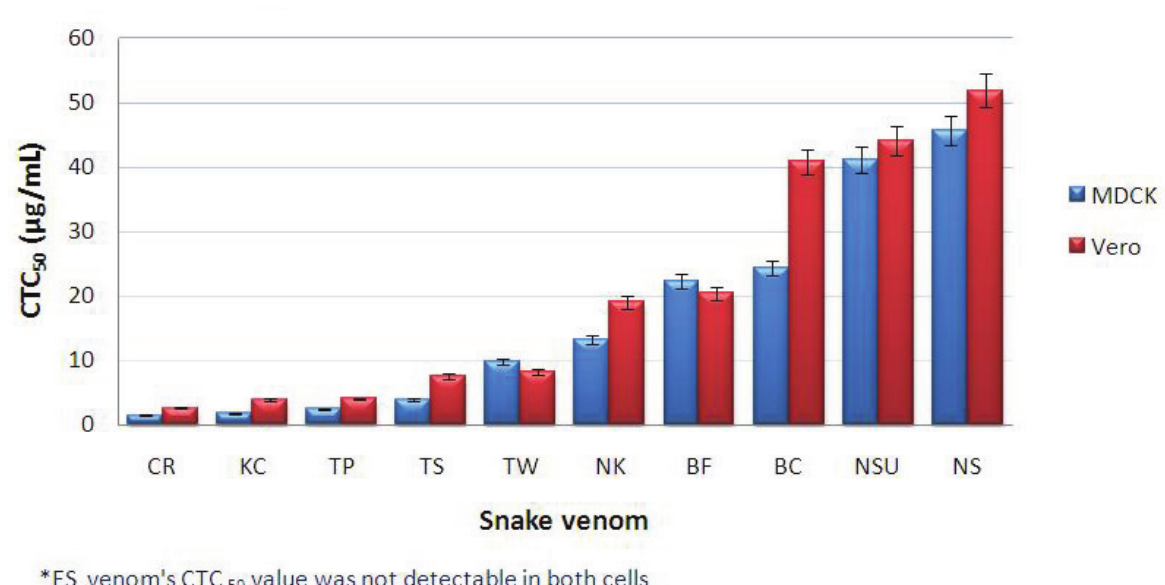
Figure 3. Cytotoxicity of Malaysian snake venoms against MDCK and Vero cells obtained by the MTS cell culture